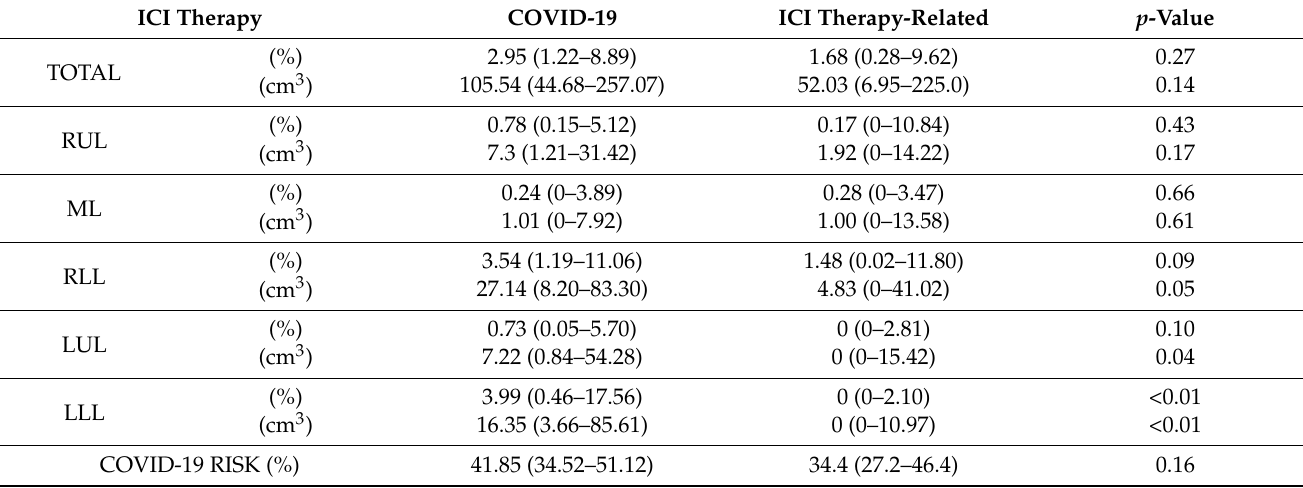
Table 3. Comparison between COVID-19 pneumonia and ICI therapy-related pneumonia based on total and lobar in- volvement. Volumes are reported as median values of the relative percentage of lobar involvement and absolute volumes. Values in parentheses are 25% and 75% percentiles that were used instead of minimum and maximum, as the value of 0 was frequent in the distribution. ICI = immune checkpoint inhibitor, COVID-19 = coronavirus disease 2019. RUL = right upper lobe, ML = middle lobe, RLL = right lower lobe, LUL = left upper lobe; LLL, left lower